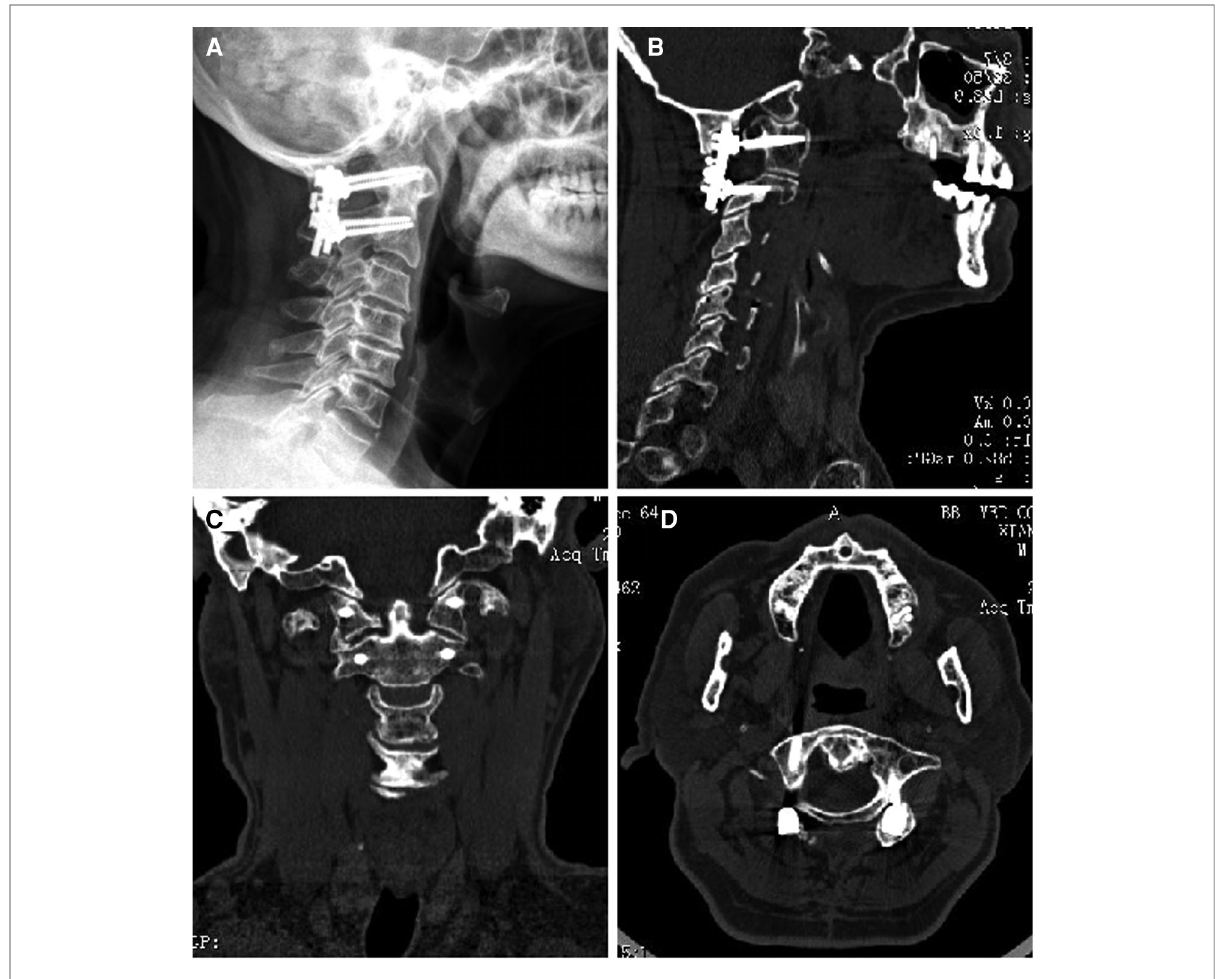
FIGURE 6 Postoperative x-ray and CT imaging